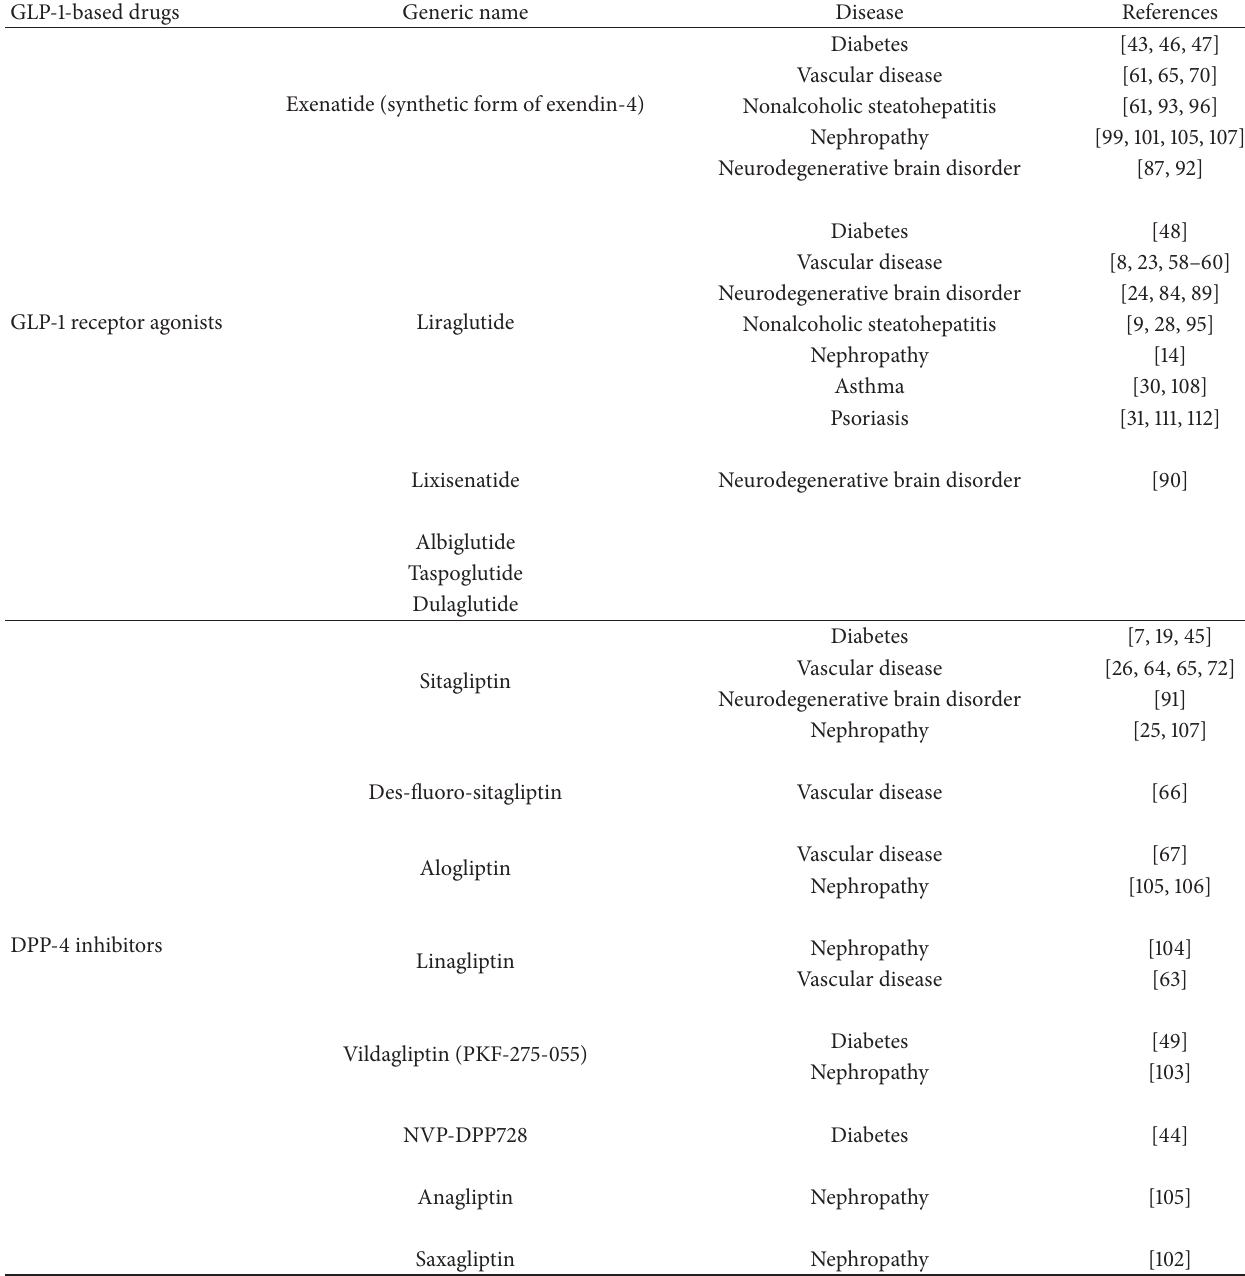
Table 1: GLP-1-based